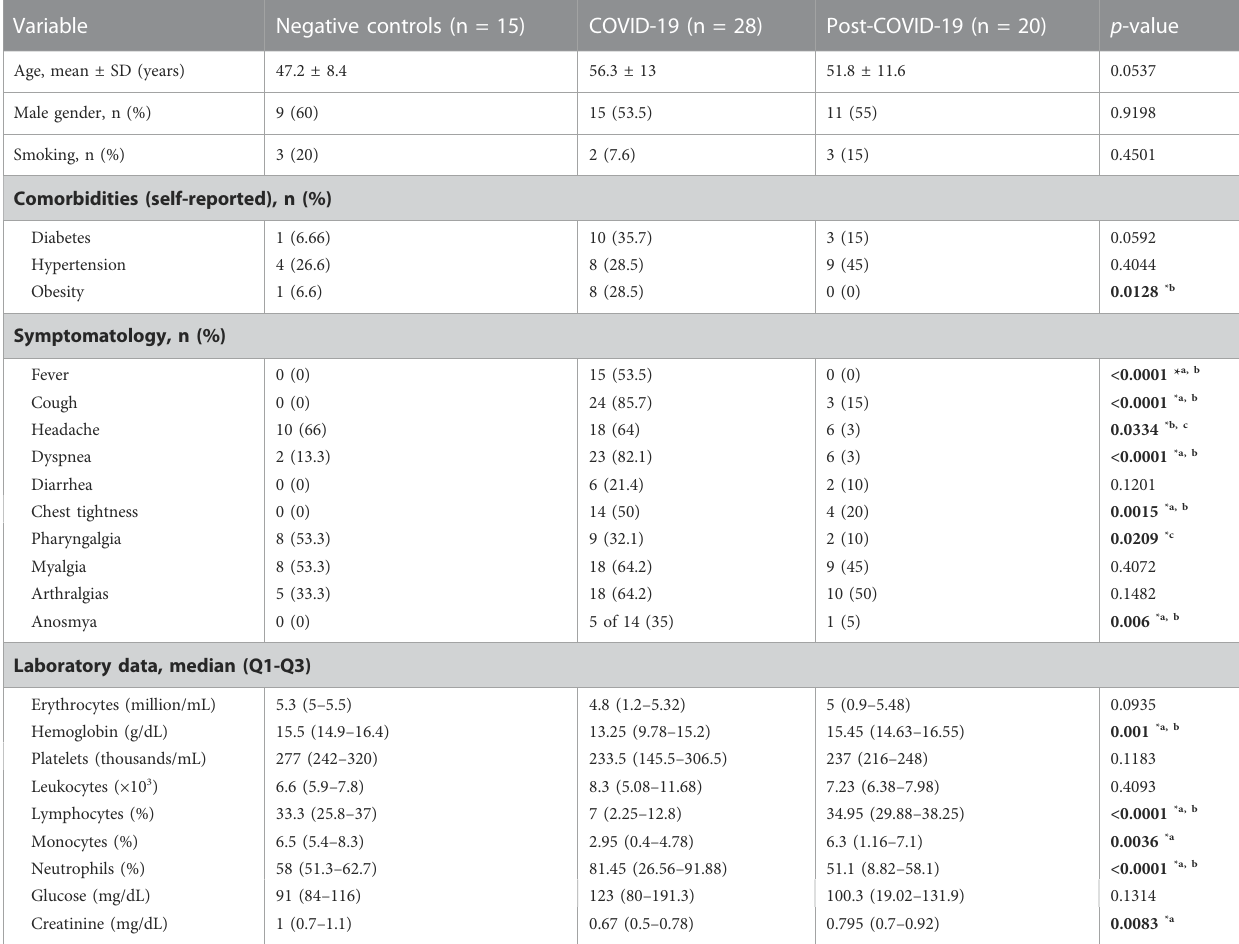
TABLE 1 Clinical and demographic